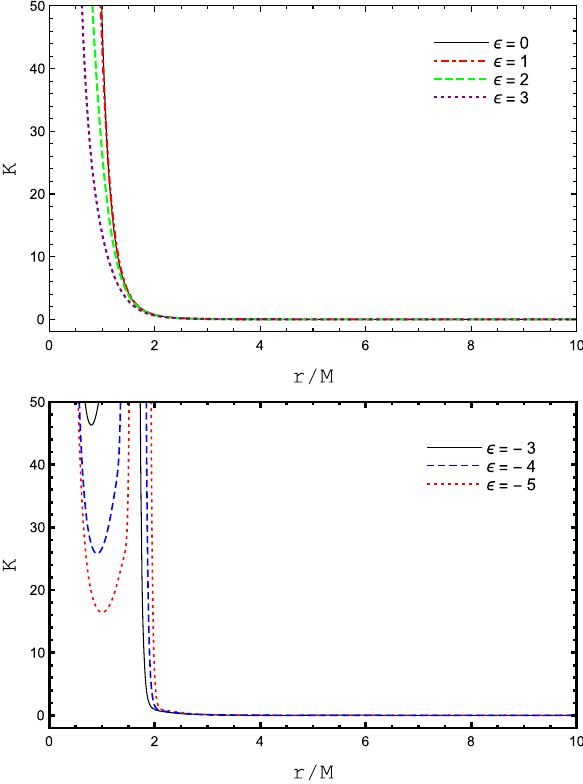
Fig. 1 Kretschmann scalar, given by Eq. (5), for some non-negative (top panel) and negative (bottom panel) values of the deformation parameter